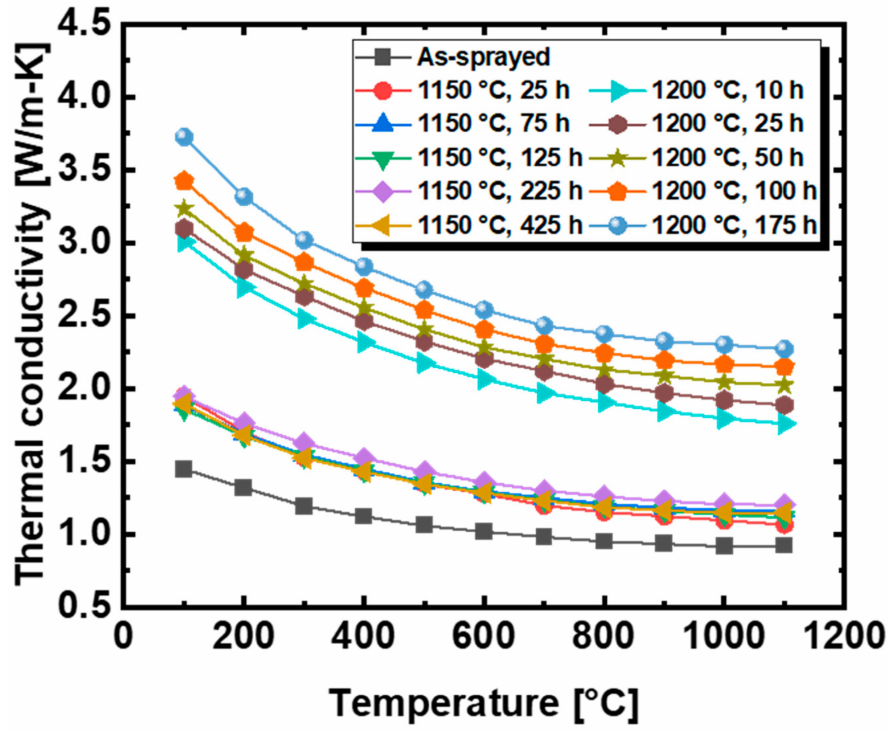
Figure 4. Thermal conductivity of as-sprayed and thermally aged